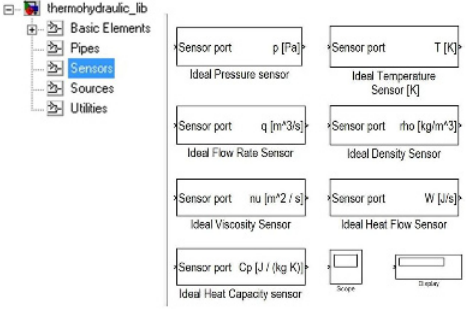
Fig. 3. Part of library containing sensors.